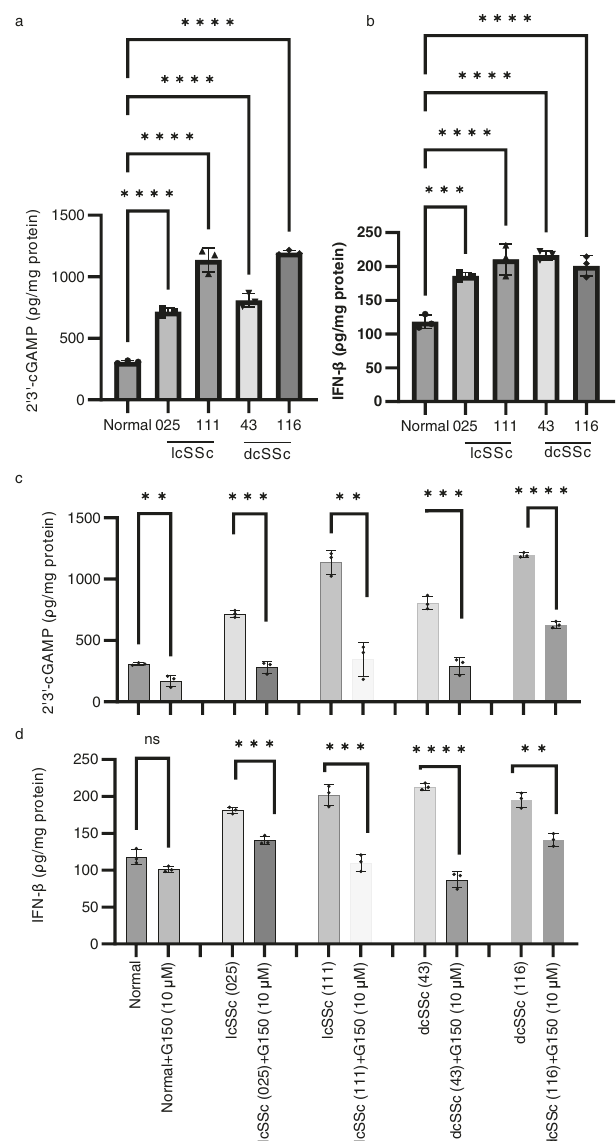
Fig. 8 | Expression of 2 ′ 3 ′ -cGAMP and IFN- β in SSc skin fi broblasts and inhibi- tionofcGAS-STING/IFN- β activitywithacGASinhibitor. ELISAswereperformed to measure the levels of expression of 2 ′ 3 ′ -cGAMP ( a ) and IFN- β ( b ) in cell lysates andsupernatants,respectively,incultured skin fi broblastsfromhealthy,lcSSc(025 and 111), and dcSSc (43 and 116) individuals. Inhibition of the cGAS-STING/IFN- β pathwaywas assessed using the cGASspeci fi c inhibitor G150. After treatment with G150 (10 µ M) for 2h cells were cultured for additional 24h and the levels of of expression of 2 ′ 3 ′ -cGAMP ( c ) and IFN- β ( d ) were evaluated using ELISA. Data are presented as mean values+/ − SD ( n =3 independent experiments). Data were analyzedusingone-wayANOVAandDunnett ’ smultiplecomparisonstest.* p